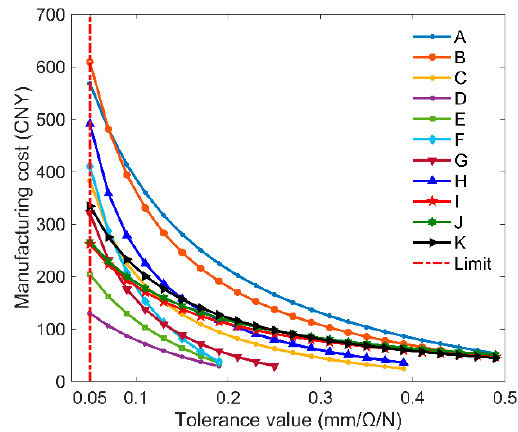
Figure 5. Manufacturing cost models of input variables.